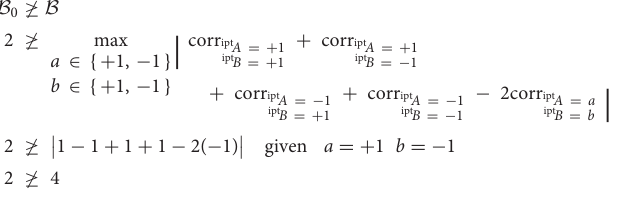
to be maximally contextual due to the degree that it’s Bell parameter B violates the bound B 0 of non-contextual hidden variable